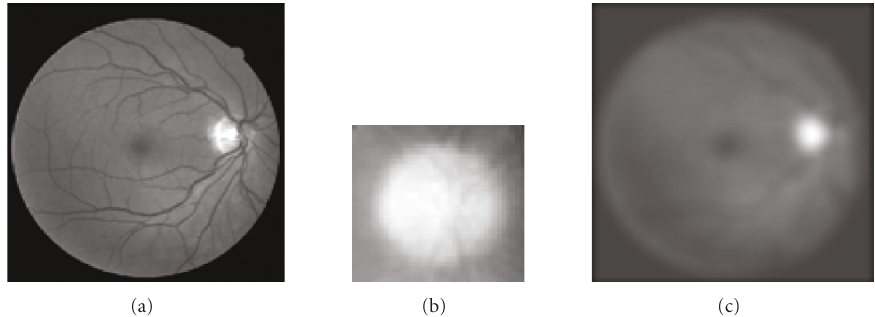
Figure 5: Optical disk localization: (a) original image, (b) template, and (c) correlated image.